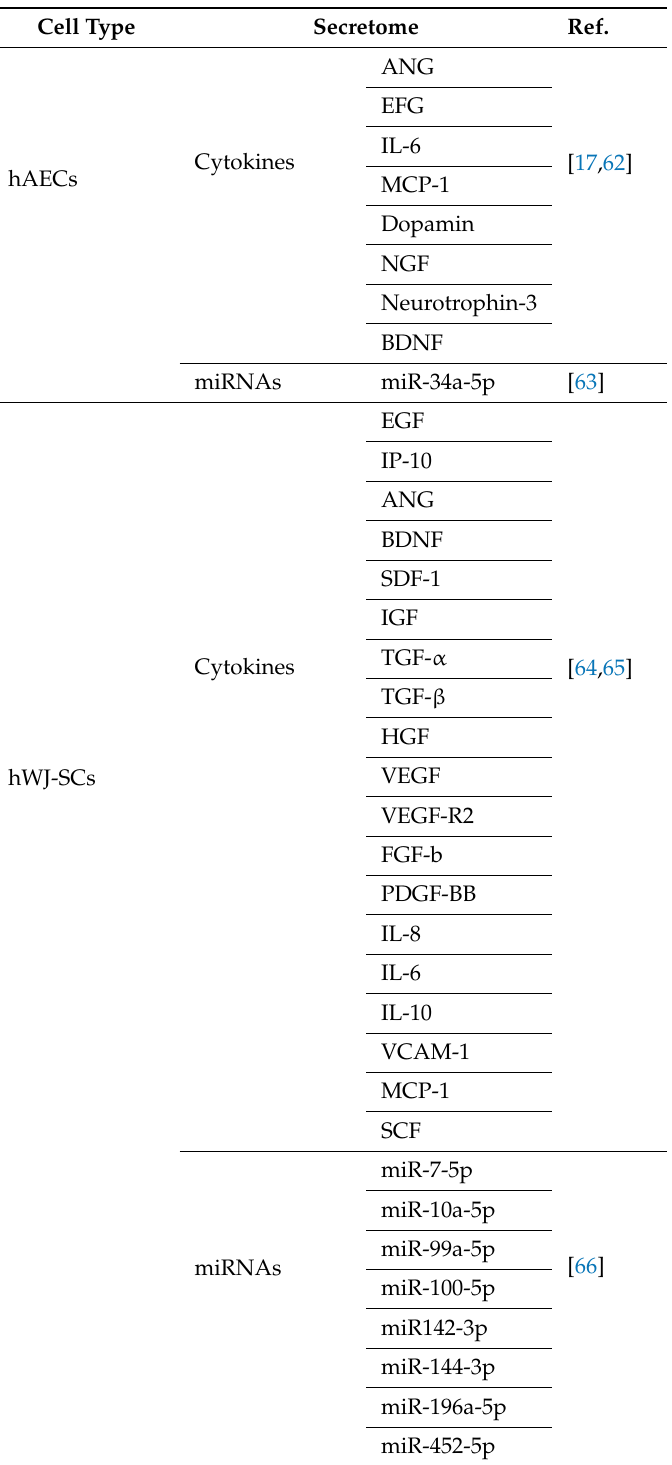
Table 3. Secretome of fetal annex-derived stem